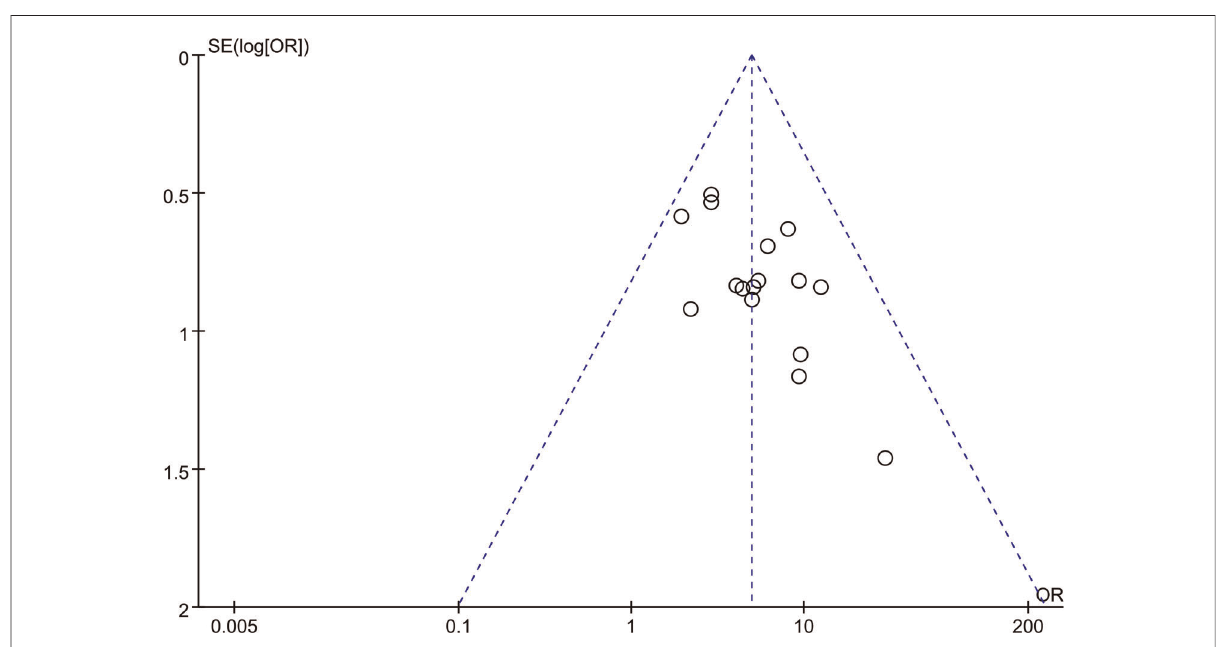
FIGURE 13 A funnel plot showing publication